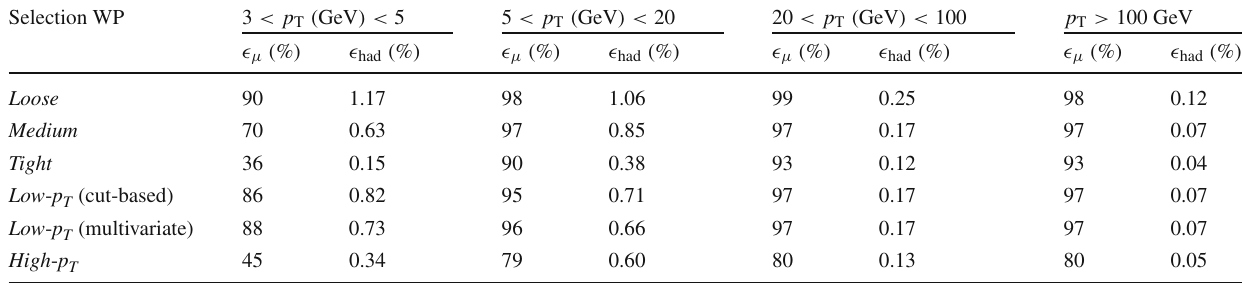
Table 1 Prompt-muon efficiencies (cid:14) μ and light-hadron misidentifica- tion rates (cid:14) had for the different selection working points, evaluated in a t ¯ t MC sample in different p T regions for | η | < 2 . 5. It should be noted that the Tight WP by construction does not select any muons with Selection